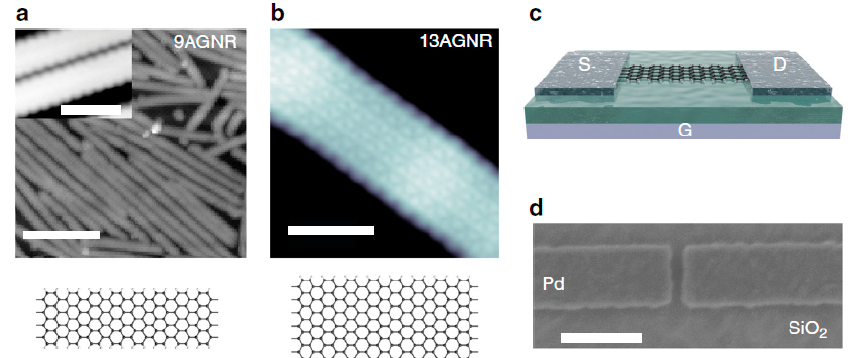
Figure 62. High-resolution scanning tunneling microscope (STM) graphene nanoribbons (GNR) characterization and FET structure: ( a ) STM image of synthesized 9AGNR on Au with a scale bar of 10 nm (V s = 1 V, I t = 0.3 nA). Inset: High-resolution STM image of 9AGNR on Au (V s = 1 V, I t = 0.5 nA) with a scale bar of 1 nm, ( b ) high-resolution STM image of 13AGNR on Au with a scale bar of 2 nm (V s = − 0.7 V, I t = 7 nA), ( c ) schematic of the short channel GNRFET with a 9AGNR channel and Pd